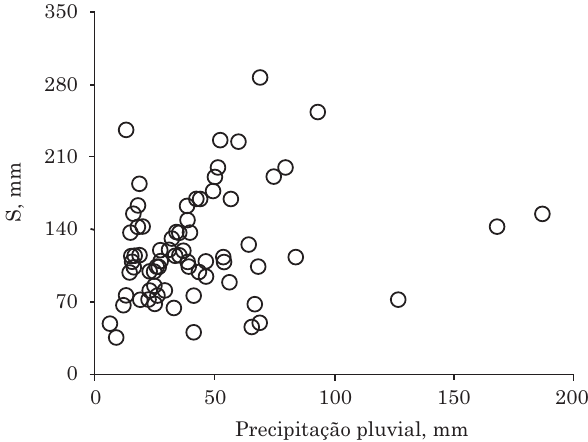
Figura 2. Relação entre o valor de S (Método da Curva Número) e a precipitação pluvial dos eventos monitorados.